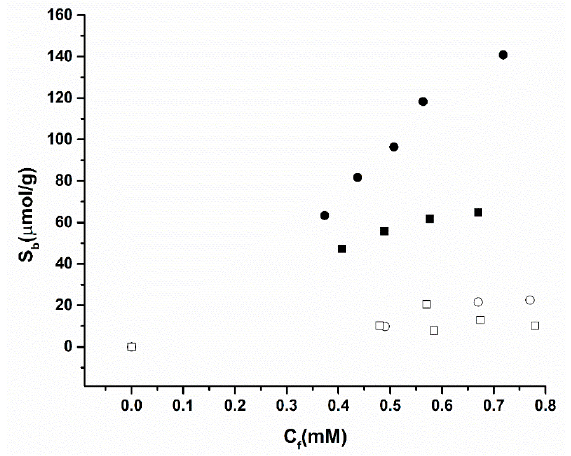
Figure 3. Selectivity batch rebinding of MIP 2 ( filled symbols ) and NIP 2 ( hollow symbols ) with amoxicillin ( squares ) and nafcillin ( circles ) in PBS.